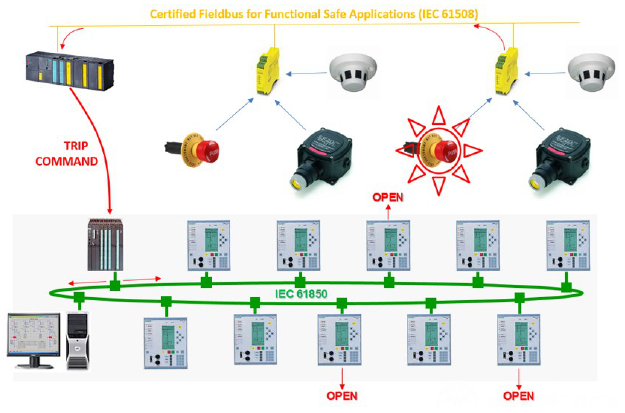
Fig. 2. Example of safety system interaction with IEC 61850